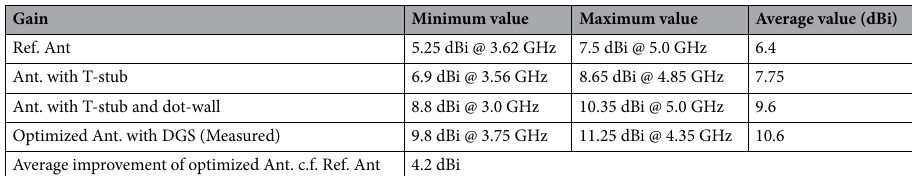
Table 3. Antenna array gain.